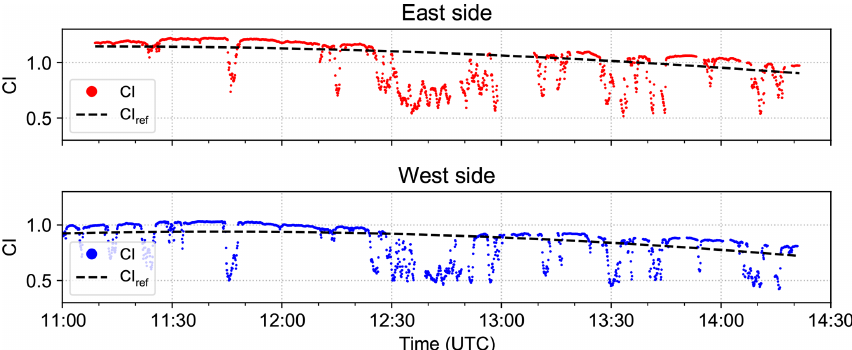
Figure B2. The colour index (CI; intensity ratio 320nm / 440nm) for both measurement series. The dashed line (CI ref ) indicates the filter threshold.